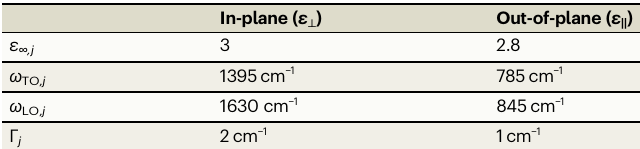
Table 3 | Parameters for calculating the permittivity of CBP according to Eq.